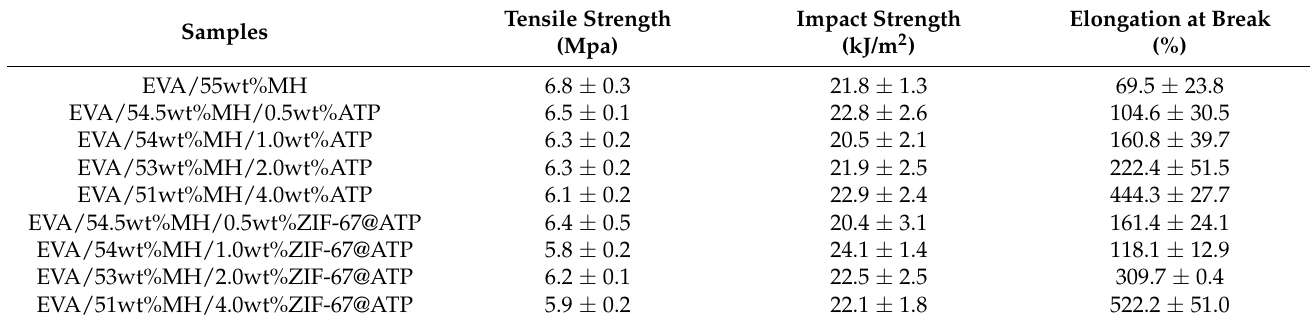
Table 4. Mechanical properties data of EVA and EVA